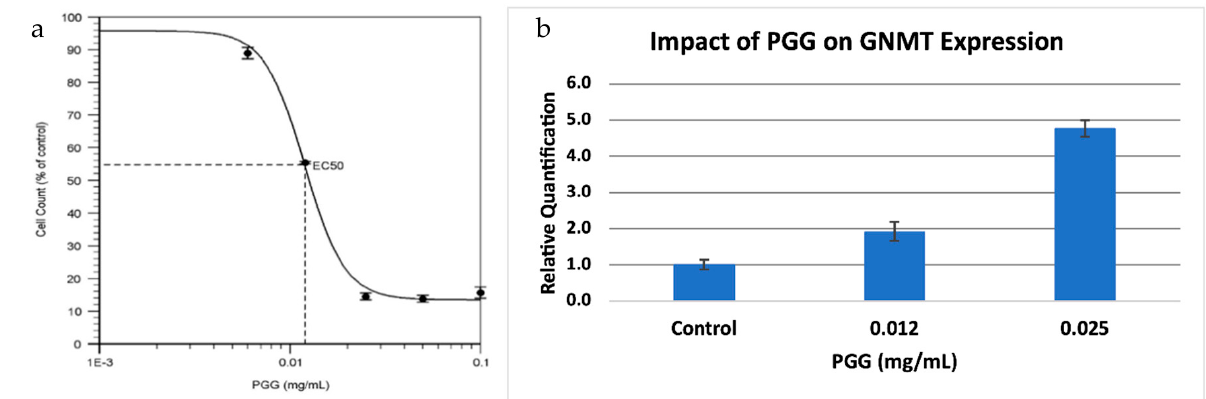
Figure 4. Treatment of a pancreatic cancer cell line with PGG. ( a ) Dose-response viability curve for BxPC-3 treated with PGG. The EC 50 value of PGG for BxPC-3 is 12 ng/mL. Results are the mean ± SD ( n = 3). ( b ). Relative Quantification (RQ) of the expression of GNMT in BxPC-3 treated with PGG, by qRT-PCR. The expression of GNMT was determined and normalized to GAPDH. The Relative Quantification of the control (0.00 mg/mL PGG) was set to 1. The cells were treated with PGG 24 h after seeding, and harvested after 72 h. Results are mean ± SD ( n =